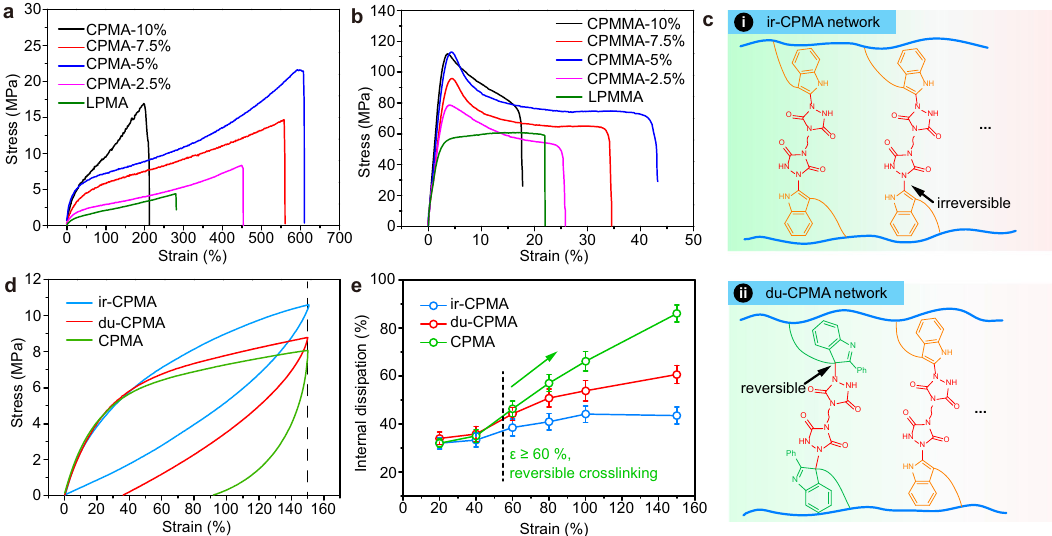
Fig. 4 Uniaxial tensile and recovery. Stress as a function of strain of a CPMA ( _ ε = 20 mm min − 1 ) and b CPMMA ( _ ε = 2 mm min − 1 ) fi lms. c Structural representation of irreversible crosslinked PMA (ir-CPMA), and dual crosslinked CPMA (du-CPMA) containing a 1:1 ratio of reversible and irreversible crosslinks. d One cyclic stretching of different crosslinked fi lms at 40 o C. e The mechanical internal friction dissipation of the three networks at different strains. The error bar was derived from fi ve tests of internal